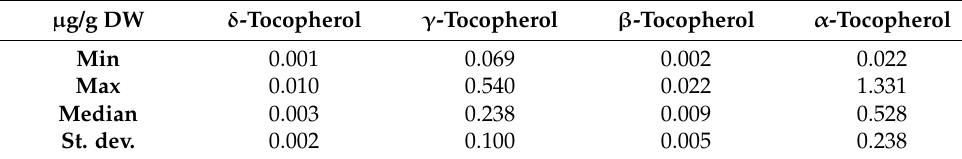
Figure 3. The amounts and standard errors of tocopherols in investigated seeds of apple cultivars grown in Norway. grown in Norway. Table 5. Statistical parameters for tocopherol. Table 5. Statistical parameters for